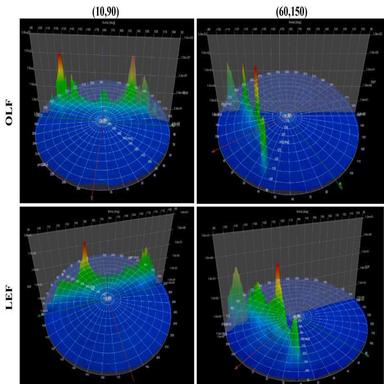
Distribution of light transmitted through under-study materials in a specified theta and phi angle (θ, φ).